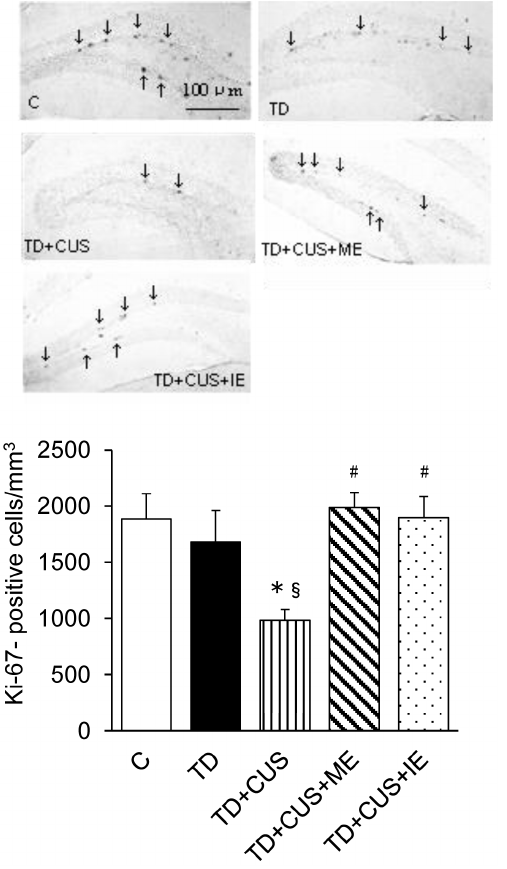
Figure 7. Effects of tryptophan deficiency, CUS and regular exercise on number of Ki67-positive cells in the dentate gyrus of the hippocampus. Data are expressed as mean 6 SEM. *, p , 0.05 vs. C; 1 , p , 0.05 vs. TD; # , p , 0.05 vs. TD +